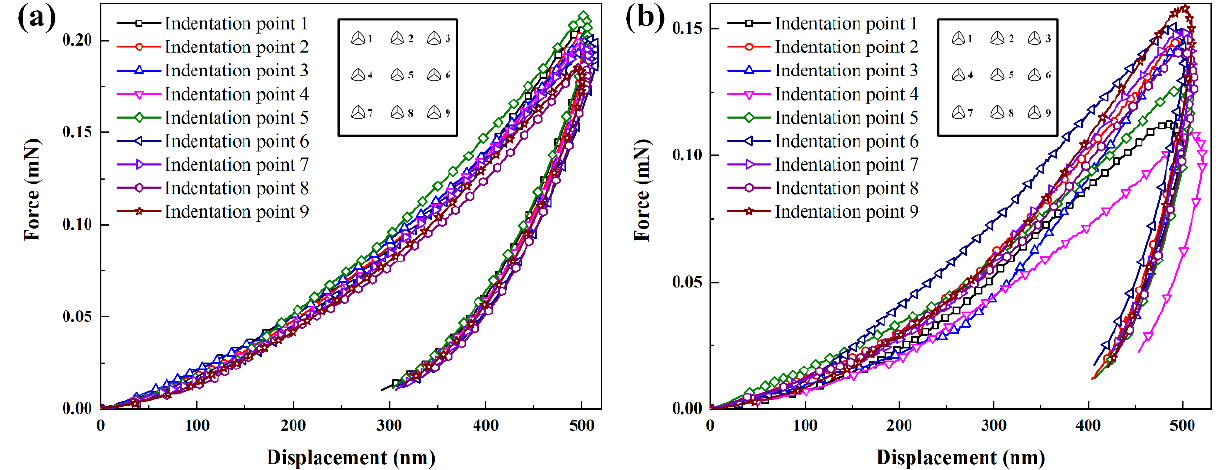
Figure 3. The displacement–force curves of specimens at different indentation points: ( a ) specimen 1; ( b ) specimen 2.